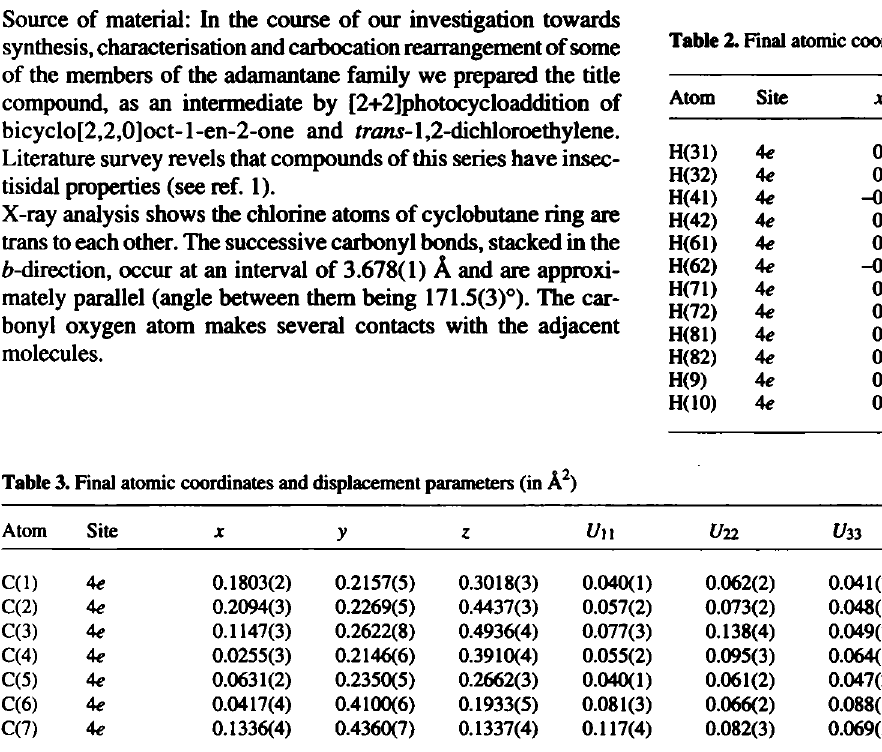
Table 2. Final atomic coordinates and displacement parameters (in Â 2 )